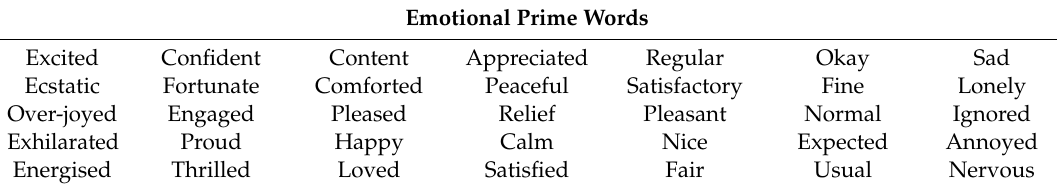
Table 2. Emotional prime words used in the a ff ective priming task.